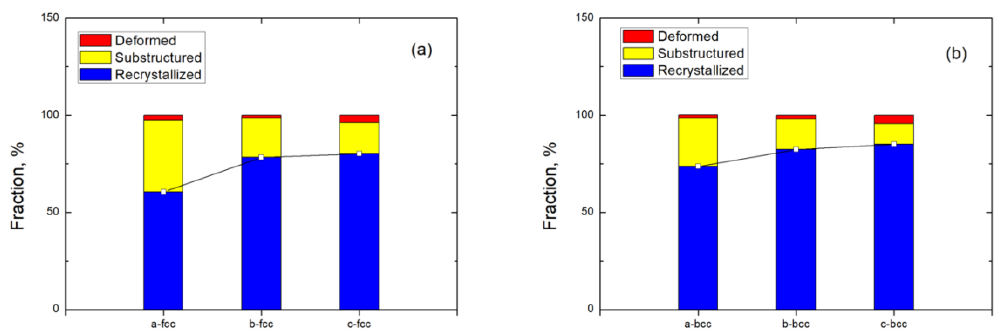
Figure 14. The fraction of the recrystallized, substructured, deformed grains at different regions along the centerline of FSPed specimen: ( a ) austenite and ( b ) ferrite.